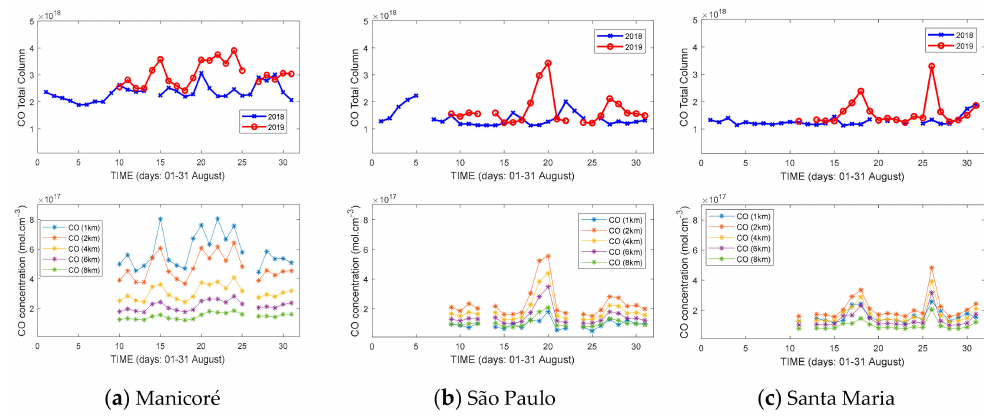
Figure 4. CO time evolution during August 2019, over ( a ) Manicor é (5.8 ◦ S, 61.3 ◦ W), ( b ) S ã o Paulo (23.5 ◦ S, 46.6 ◦ W) and ( c ) Santa Maria (29.4 ◦ S, 53.8 ◦ W) sites, as seen by IASI instrument. CO total columns are given in the upper panels, while CO concentrations at tropospheric heights (1, 2, 4, 6 and 8 km) are in the lower panels (according to the legend). For comparison, the August-2018 CO columns are superimposed in blue in the upper